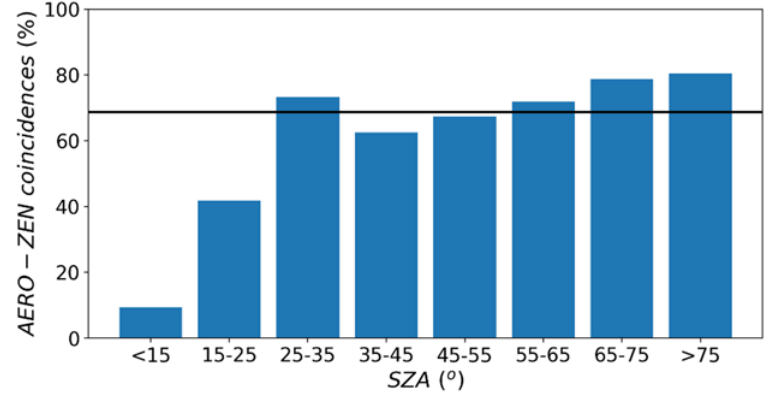
Figure 4. AOD at 500 nm for a 10 ‐ month period (August 2017 to June 2018) at Izaña station obtained from ZEN ‐ R52 and CE318 ‐ AERONET radiometers. Grey crosses represent ZEN ‐ R52 unfiltered AOD data, red solid circles depict ZEN ‐ R52 AOD after applying the ZEN ‐ QC algorithm, and blue squares show CE318 ‐ AERONET level 2.0 AOD data.